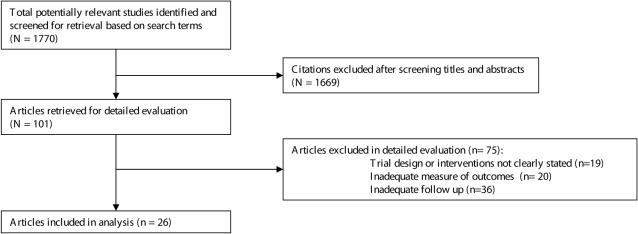
Article selection flowchart.